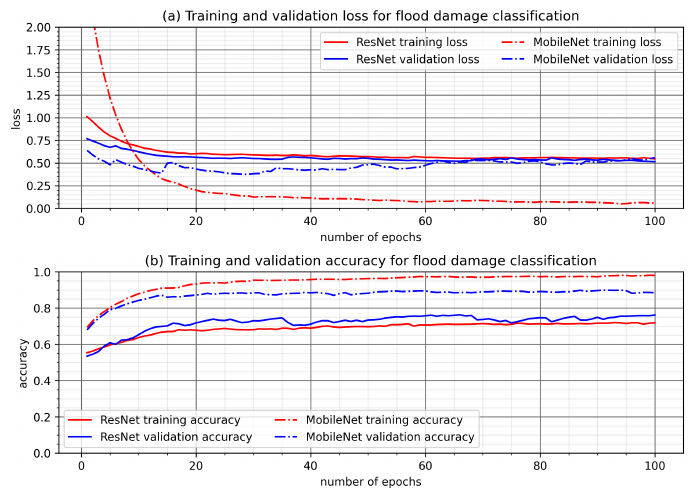
Figure 3. The training and validation cross-entropy loss and accuracy for the flood damage classifica- tion using ResNet and